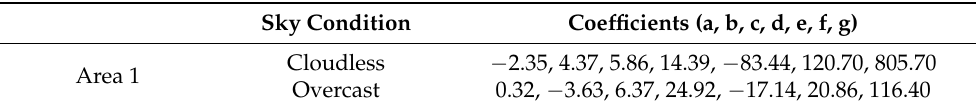
Table 2. Polynomial coefficients for determining the DNI based on ND , for cloudless (Cloudl.) and overcast (Overc.) skies at the pixel